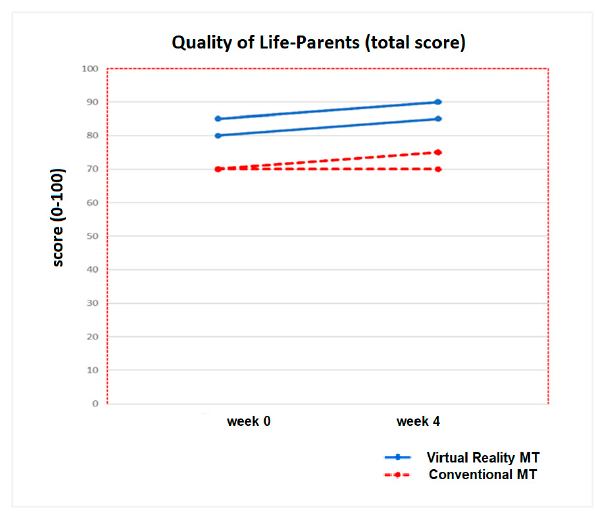
Figure 6. Progression of the Quality of life- Parents (total score) of the ten children who completed both therapies (Virtual Reality MT: 5 children and Conventional MT: 5 children).